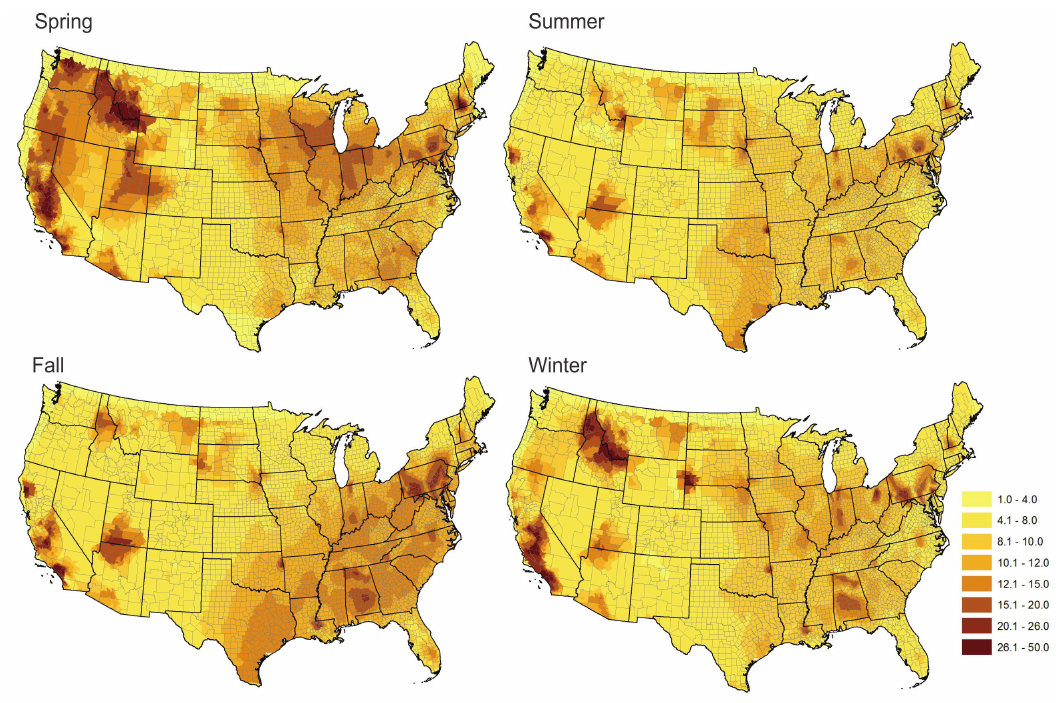
Figure 5. Seasonal differences. The average PM 2.5 in different seasons across the contiguous United States in 2009. In order to make the color scheme consistent in four seasons, we manually defined the classification scheme. The legend shows the class